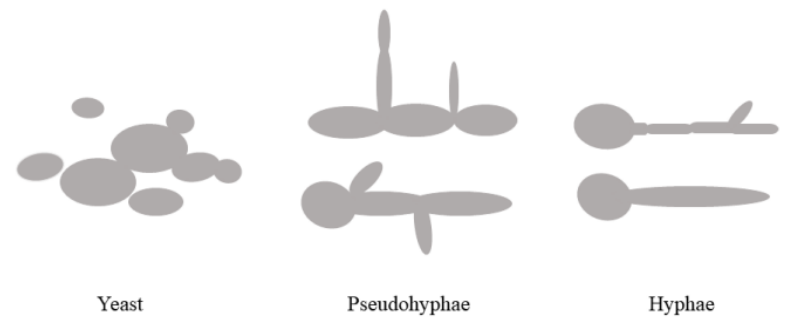
Figure 7. The three forms of C. albicans .